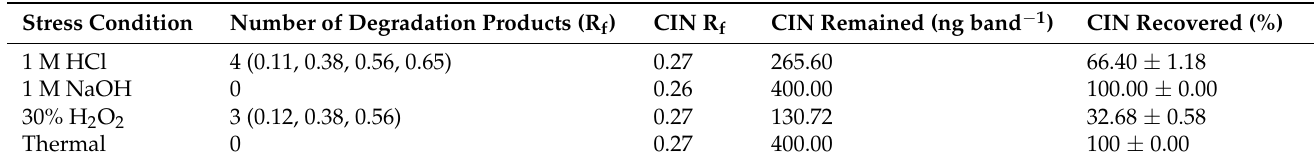
Figure 5. Typical chromatograms of CIN recorded under ( A ) acidic stress test, ( B ) basic stress test, ( C ) oxidative degradation test, and ( D ) thermal stress test of CIN. Table 6. Results of forced degradation investigations of CIN under distinct stress conditions for the present approach (mean ± SD; n = 3).